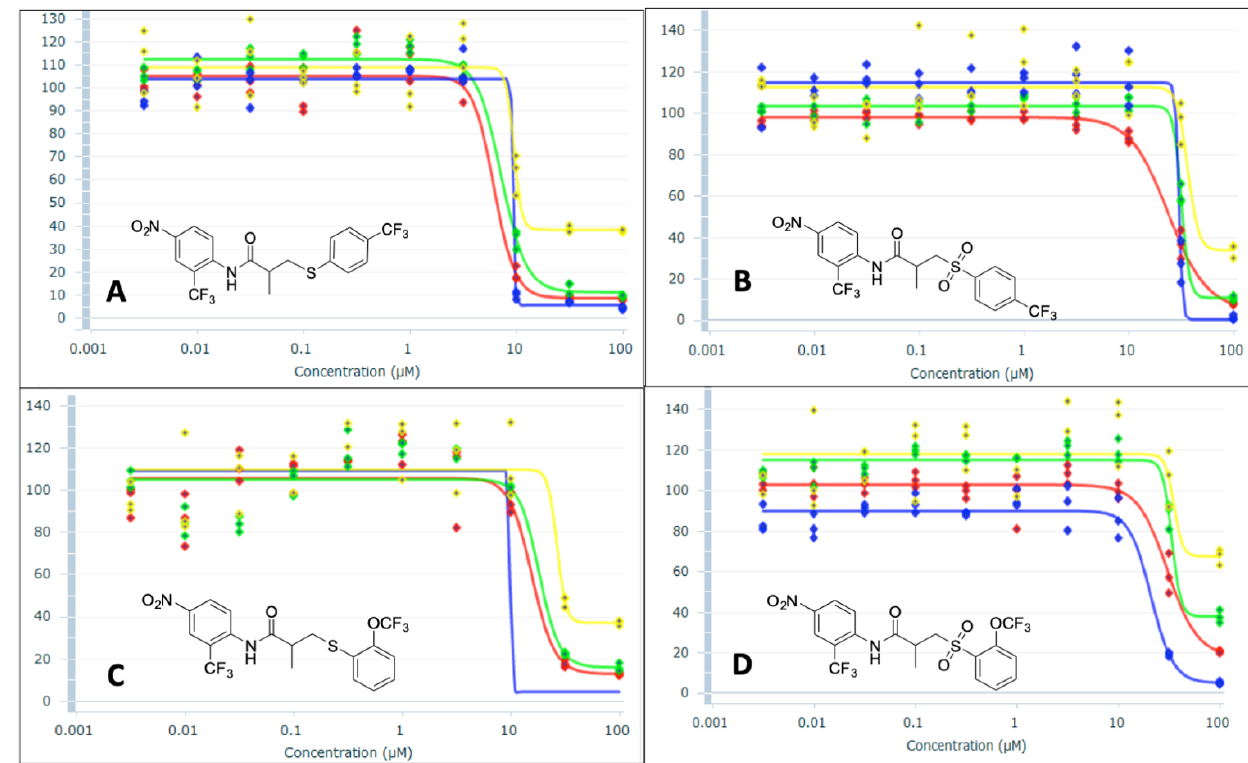
Figure 3. Dose response curves of sulfide compounds 16 ( A ) and 17 ( C ) compared to their corresponding sulfone derivatives 21 ( B ) and 22 ( D ), respectively, in the Oncotest monolayer assay of 22Rv1 (red), DU-145 (green), LnCaP (blue), and VCap (yellow) cell lines.